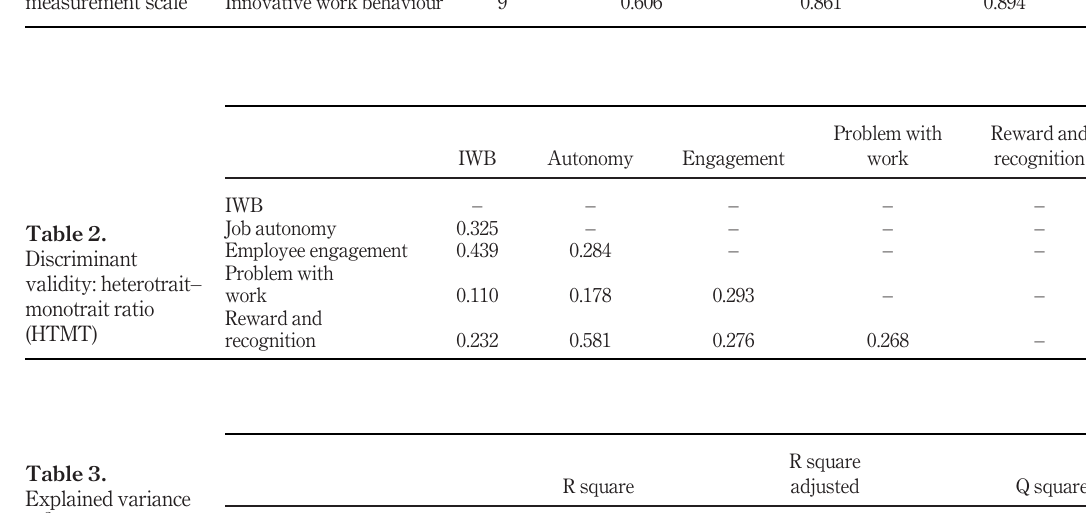
Table 1. Reliability and